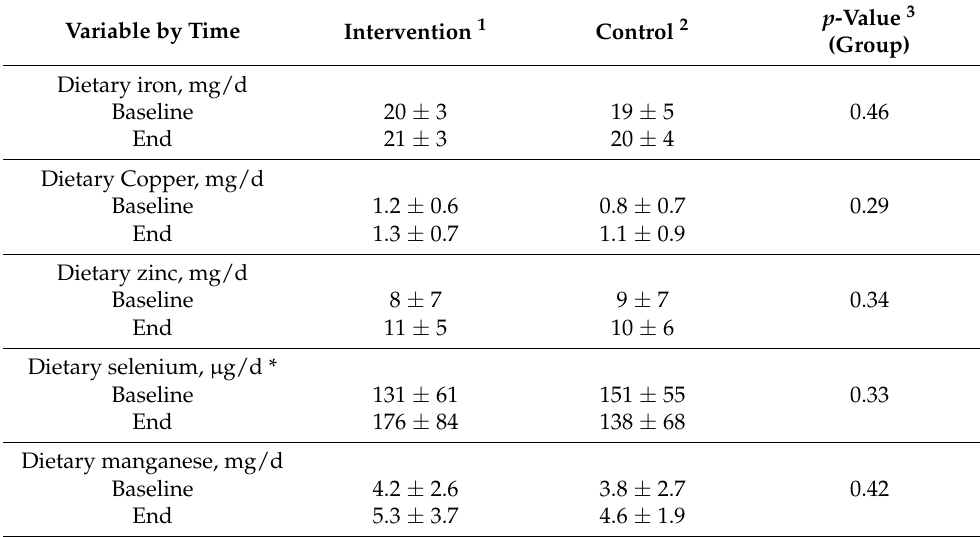
Table 4. Maternal dietary intakes of trace elements as antioxidants following dietary intervention vs. control for 18 gestation